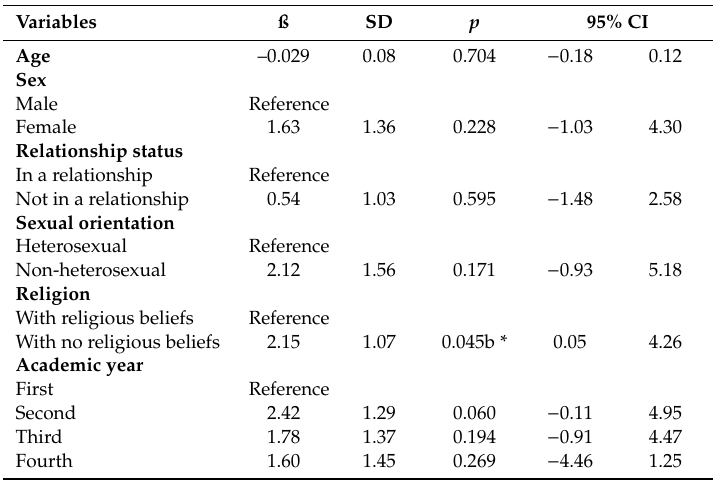
Table 4. Multiple linear regression model for the EASE